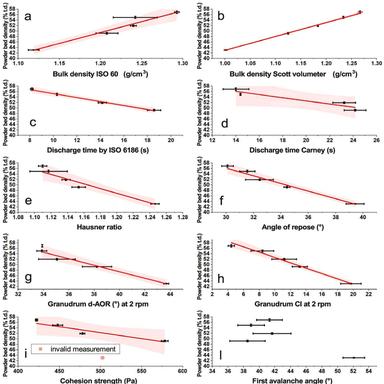
Flowability indexes plotted as a function of the powder bed density. The red line corresponds to the linear regression of the data points, and the two bands correspond to 95% confidence intervals. (a) Bulk density measured by ISO 60 (b) Bulk density measured by Scott volumeter (c) Discharge time measured by ISO 6186) (d) discharge time measured by ASTM B964–16 (Carney funnel) (e) Hausner ratio (f) Angle of repose (g) Dynamic angle of repose measured by GranuDrum at 2 rpm (h) Cohesive index measured by Granu